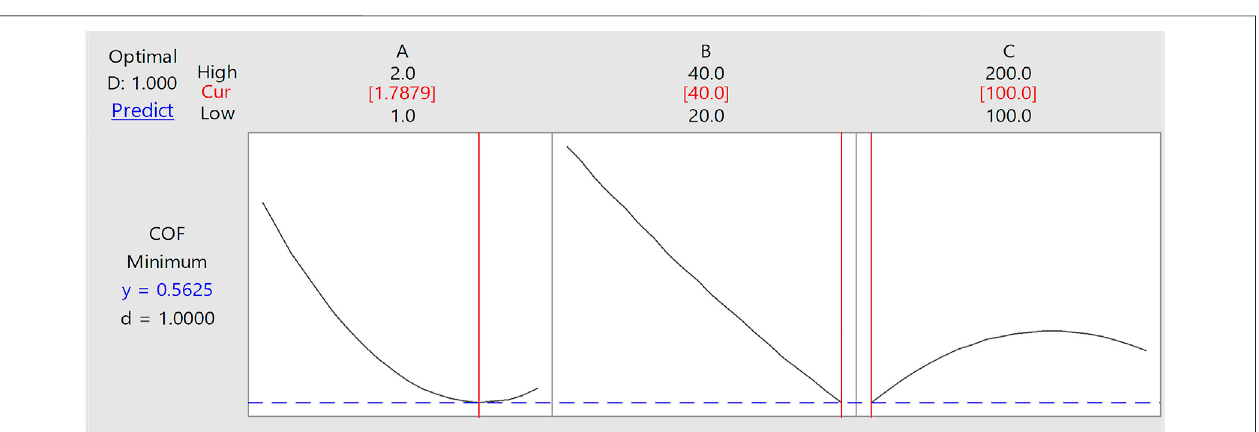
FIGURE 9 | Desirability plot for single-objective optimization of COF.